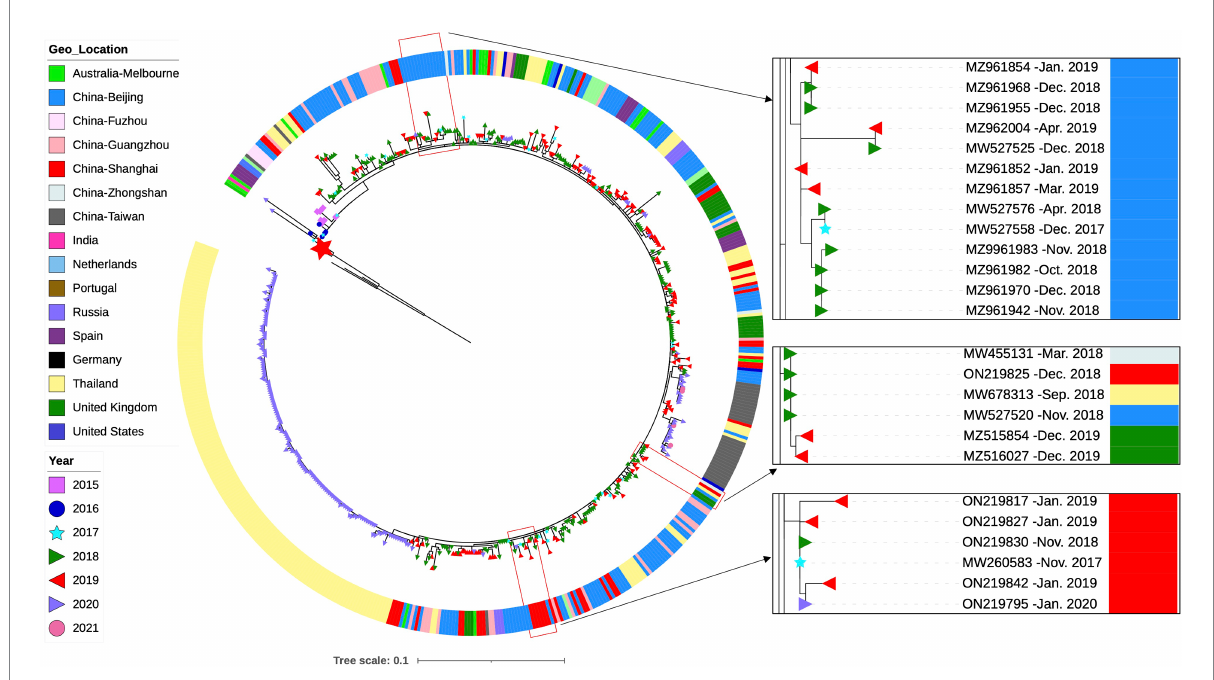
FIGURE 5 Phylogenetic analysis of all available G gene sequences of RSV-A ON1-5 strains with info on time and location of isolation. RSV-A G sequences obtained from RSV-A-positive samples in this work, and sequences with info on time and location of isolation available from GenBank were used to generate a phylogenetic tree using RAxML for genotype and lineage assignation. All ON1-5 sequences were then used to generate a phylogenetic tree using RAxML as shown here. Small branches of interest are highlighted with magnification on the right. The large red star denotes the first ON1-1 strain isolated in Ontario, Canada